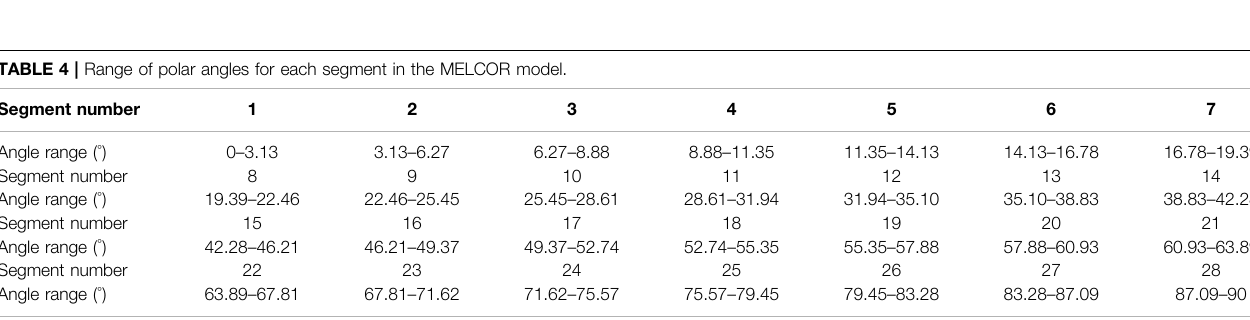
TABLE 4 | Range of polar angles for each segment in the MELCOR